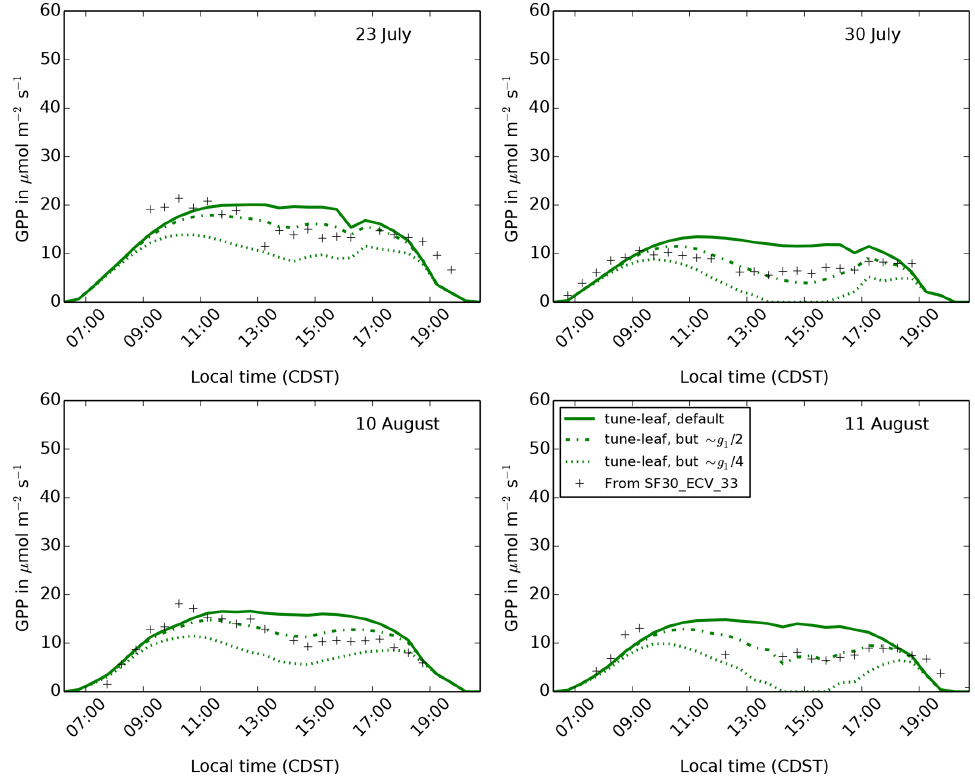
Figure 15. The diurnal cycle of GPP at site 4439 in the FIFE area for 4 days in during the dry period of 1987. Solid green lines use the tune-leaf configuration. The c i : c a ratio in this configuration closely corresponds to the c i : c a ratio for C 4 grasses in the Konza Prairie in Lin et al. (2015), using the Medlyn model and fitting the Medlyn model parameter g 1 to measurements taken in 2008 ( g 1 = g fit 1 . 04kPa − 0 . 5 ). The dot-dashed lines and dotted lines show the results from fitting the JULES parameters dq crit and f 0 to approximate the / 2 and g 1 = g fit / 4 (the parameter values are given in Table Medlyn model when g 1 = g fit 1 1